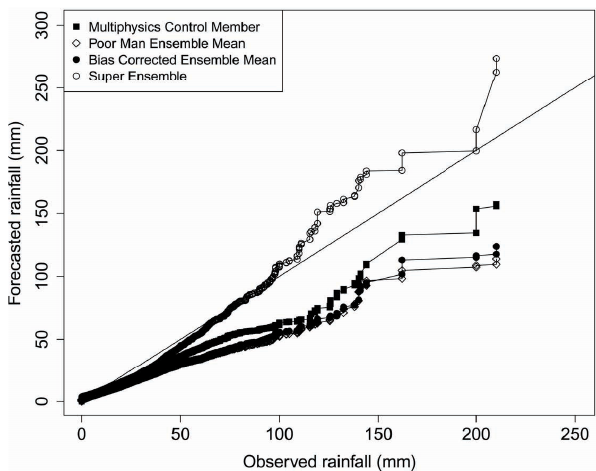
Fig. 9. Q-Q plot for the multiphysics ensemble control member, the multiphysics ensemble mean, the bias corrected ensemble mean and the superensemble, as functions of different rainfall event thresholds. Note: training period 19 MEDEX cases and forecast period September–December